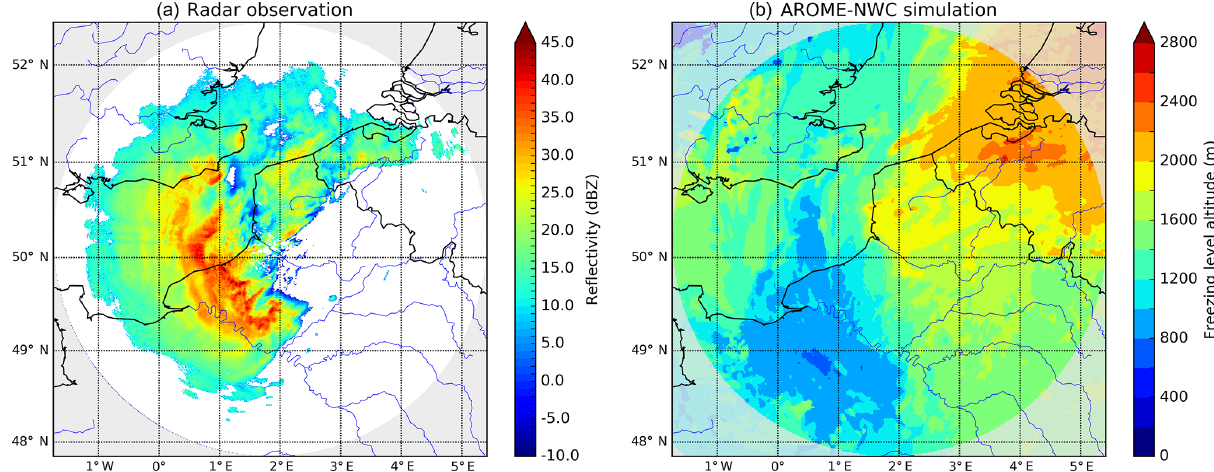
Figure 5. Observed reflectivity from the radar of Abbeville at the elevation 0.4 ◦ (a) and simulated freezing level altitude from the model AROME-NWC ( + 2h lead time) (b) on 30 April 2018 at